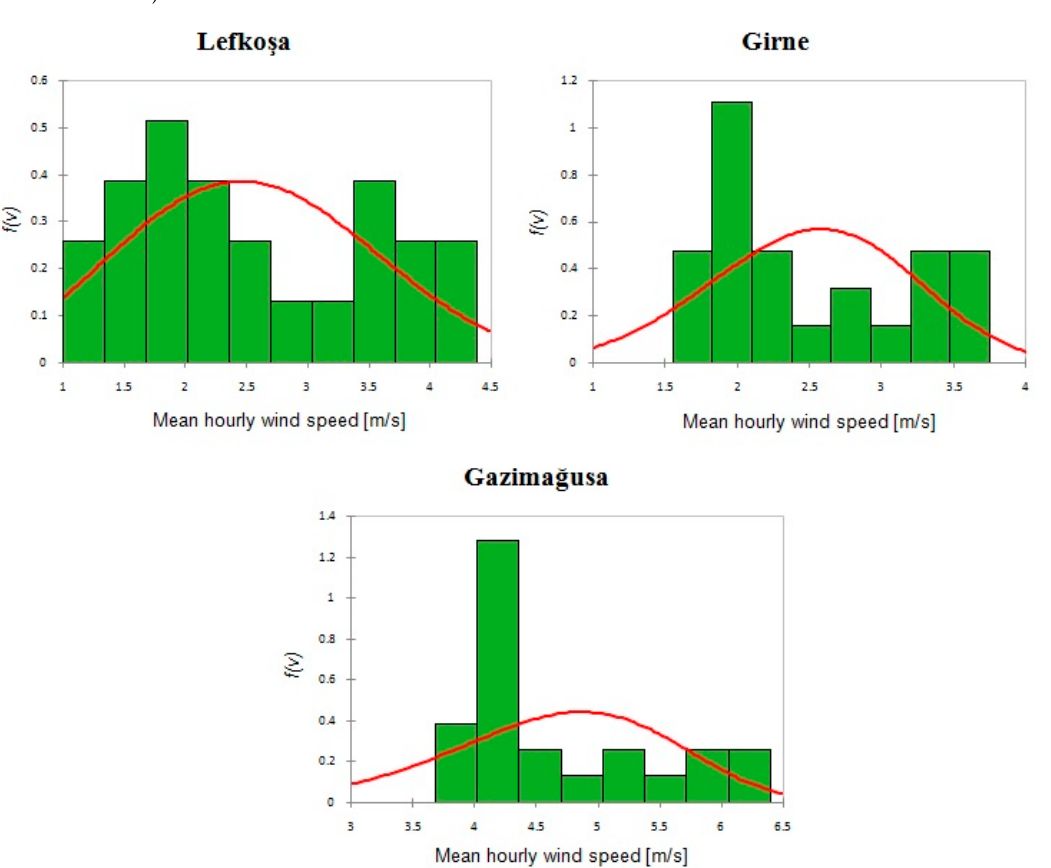
Figure 7. Wind speed probability frequency for the whole (2010–2016) at 10 m height.